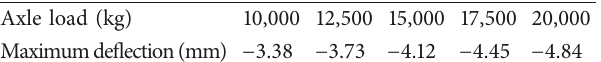
Figure 13: Comparison of the vertical displacement under different axle loads. (a) Variation with the increase of loading cycles and (b) variation along the transverse direction Z of the pavement. Table 8: The maximum surface deflections due to different axle loads after loading cycles of 1 10 6 ×